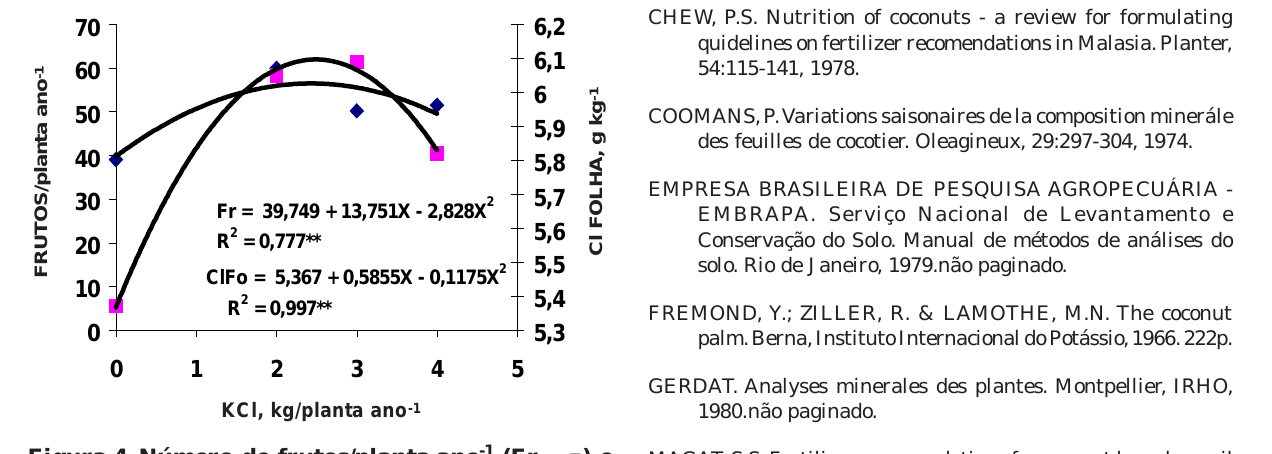
Figura 4. Número de frutos/planta ano -1 (Fr = n ) e teores de Cl na folha 14 do coqueiro (ClFo = ), em função das doses de KCl no Podzólico Amarelo. ** significativo a